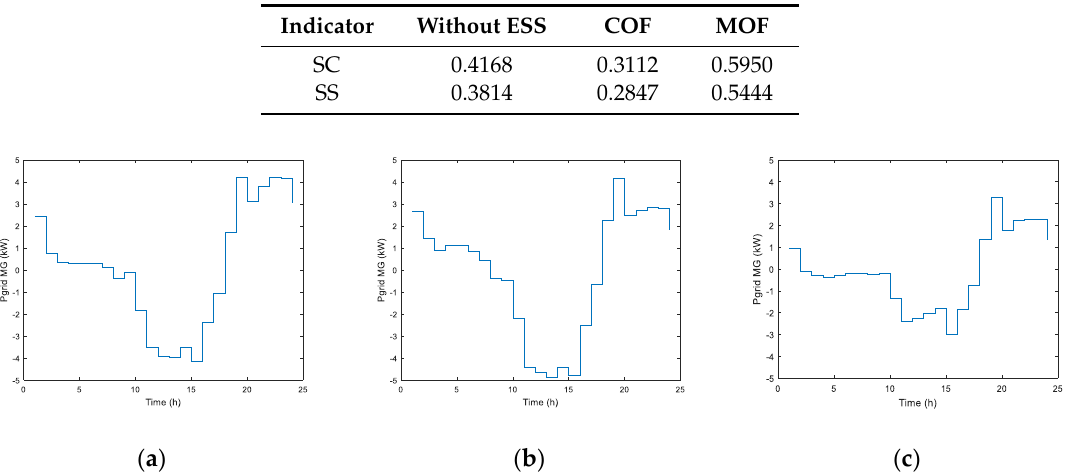
Table 4. SC and SS indicators for the whole microgrid with coordinated scheduling.